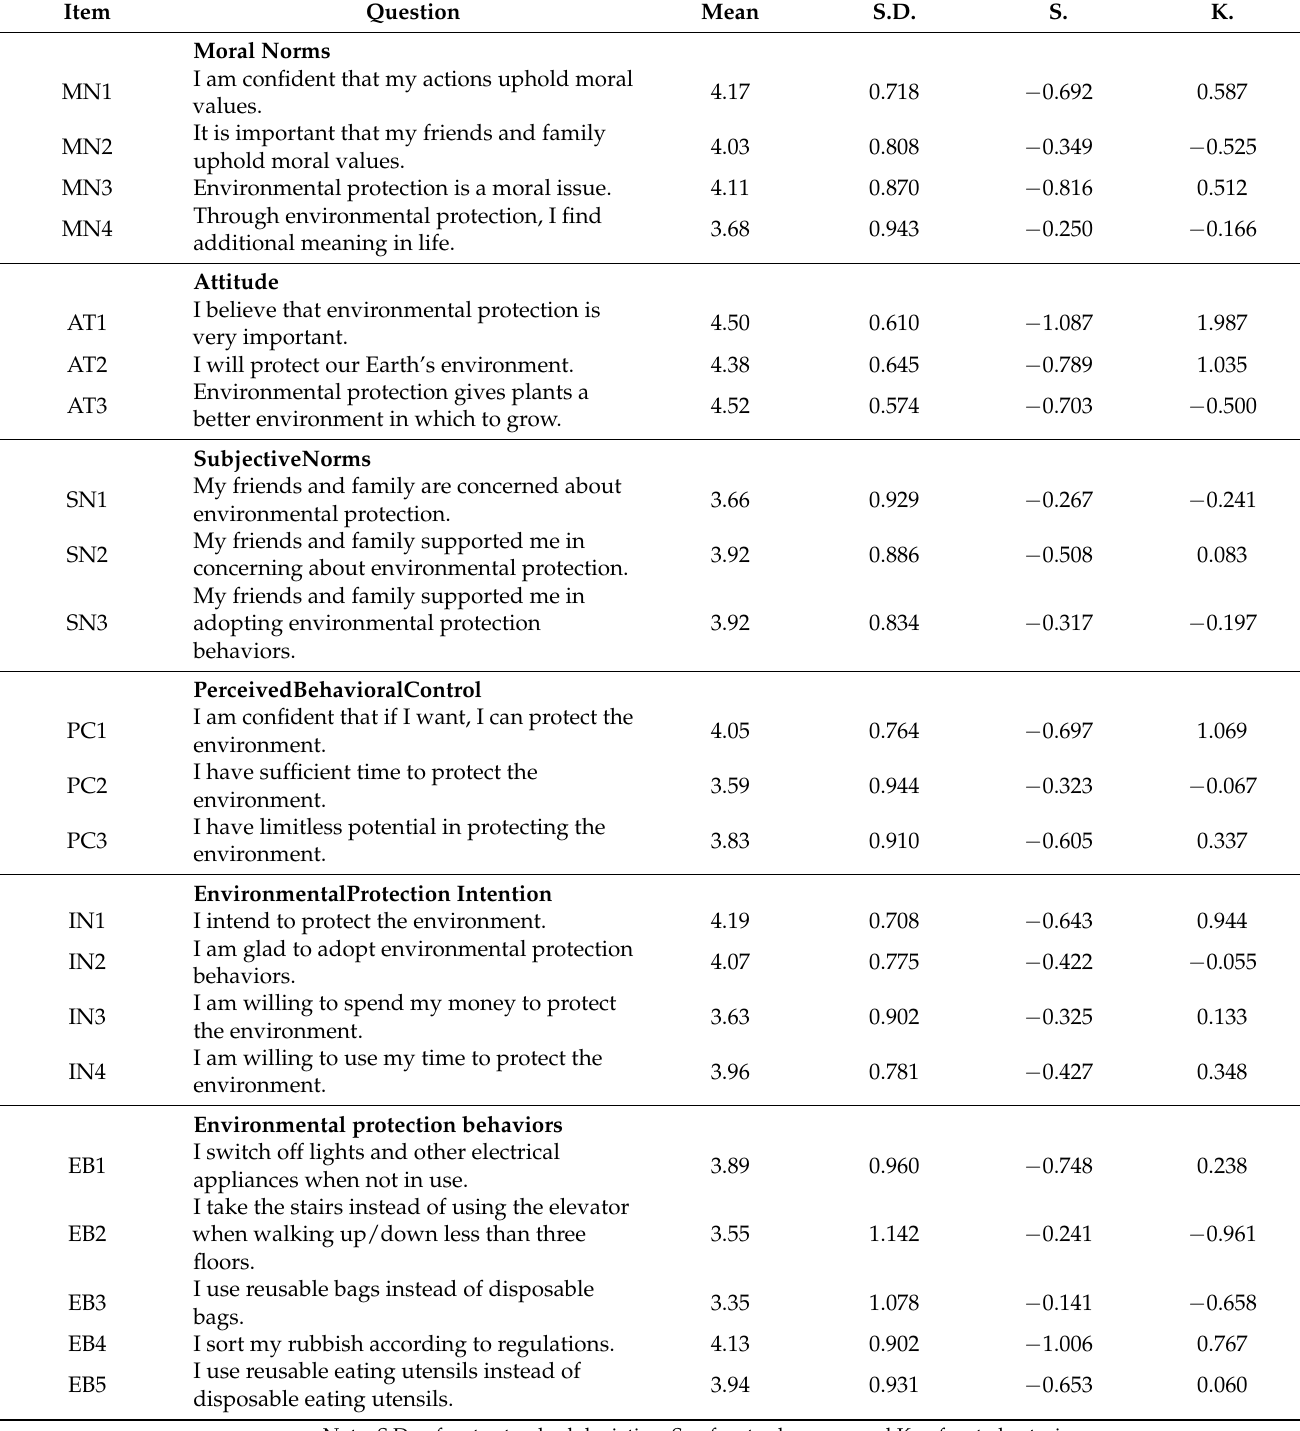
Table 2. List of constructs and their mean, standard deviation, skewness and kurtosis